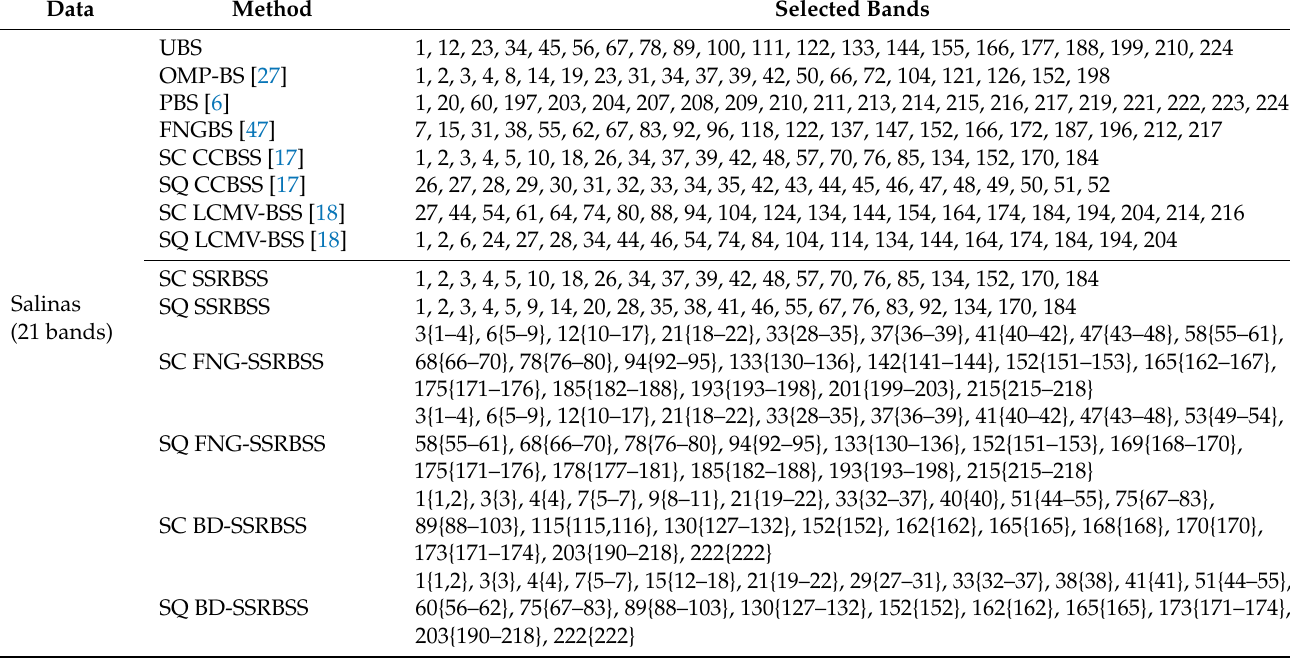
Table 5. The bands selected by the proposed and the compared methods for the Salinas